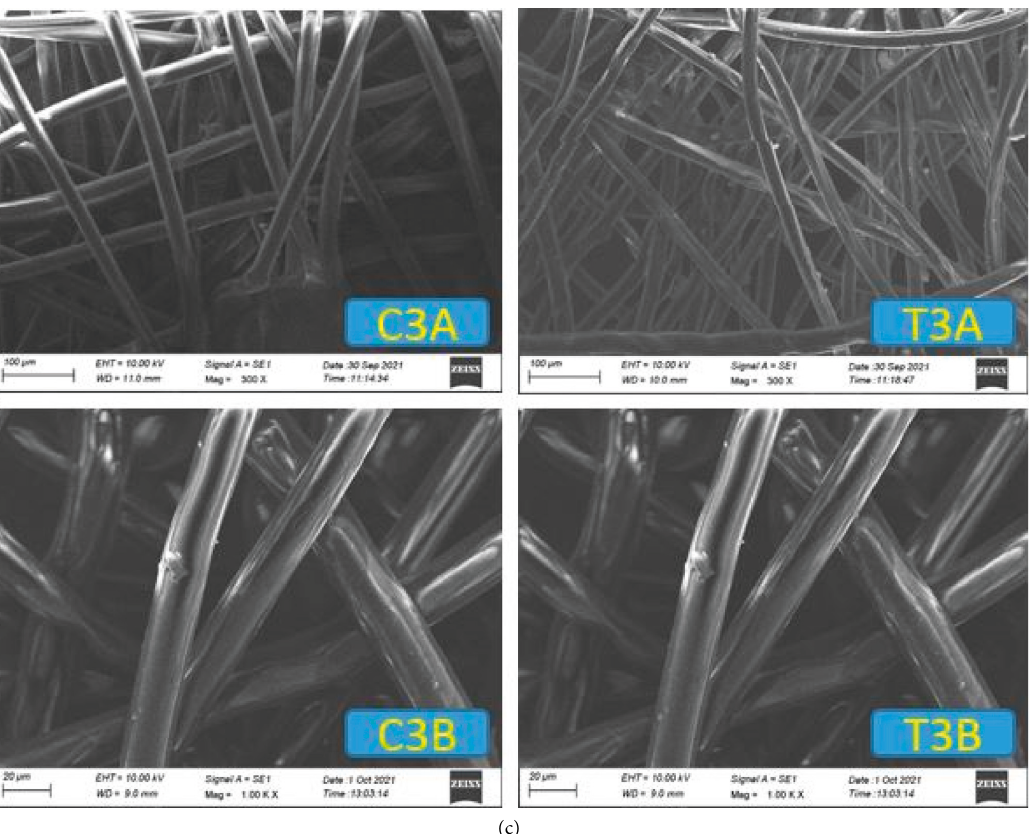
Figure 3: (a) SEM images of PP films placed in nutrient medium: C1A and C1B, control; T1A and T1B, treated with Pseudomonas sp. NA and NB media, respectively. (b) SEM images of PP films placed in BHM: C2A and C2B, control; T2A and T2B, treated with Pseudomonas sp. in BHM agar and broth, respectively. (c) SEM images of PP films placed in MSM: C3A and C3B, control; T3A and T3B, treated with Pseudomonas sp. in MSM agar and broth, respectively. Table 4: Comparison of IR band position in the PP films after incubation with Pseudomonas sp. in NB and NA (both control and test). S. no.